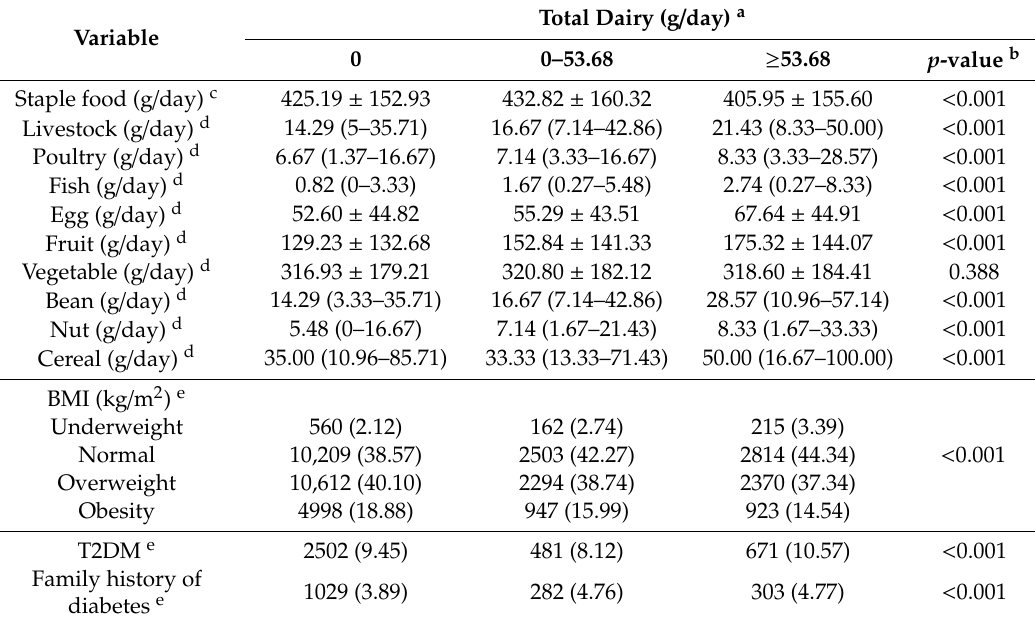
Table 2. Dietary intake and type 2 diabetes mellitus (T2DM) characteristics of participants according to the dairy intake of the Henan Rural Cohort Study.